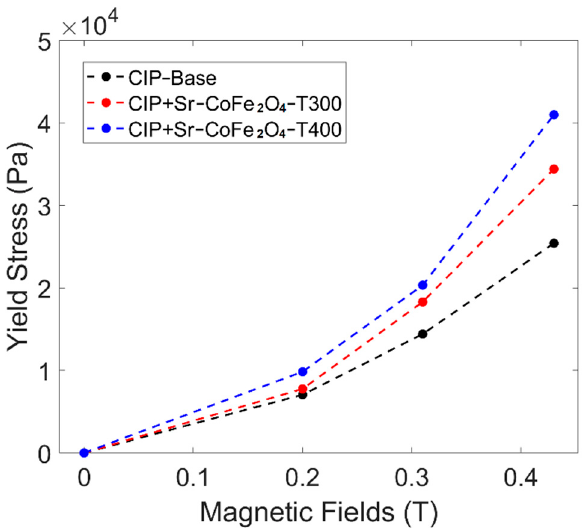
Figure 6. Viscosity curve of MRF samples against shear rate at different magnetic fields ( a ) Comparison between MRF